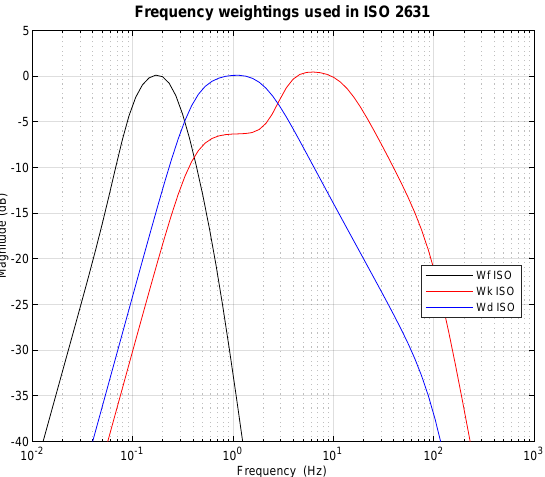
Figure 1. Acceleration filters proposed in the ISO − 2631 standard for